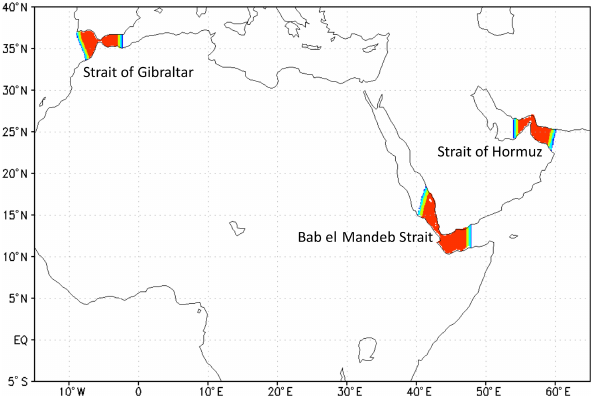
Figure 3. Timescales for restoring the temperature and salinity in and near the Straits of Gibraltar, Hormuz, and Bab el Mandeb. Red, yellow, light blue, and blue represent timescales of 1, 5, 10, and 30d,